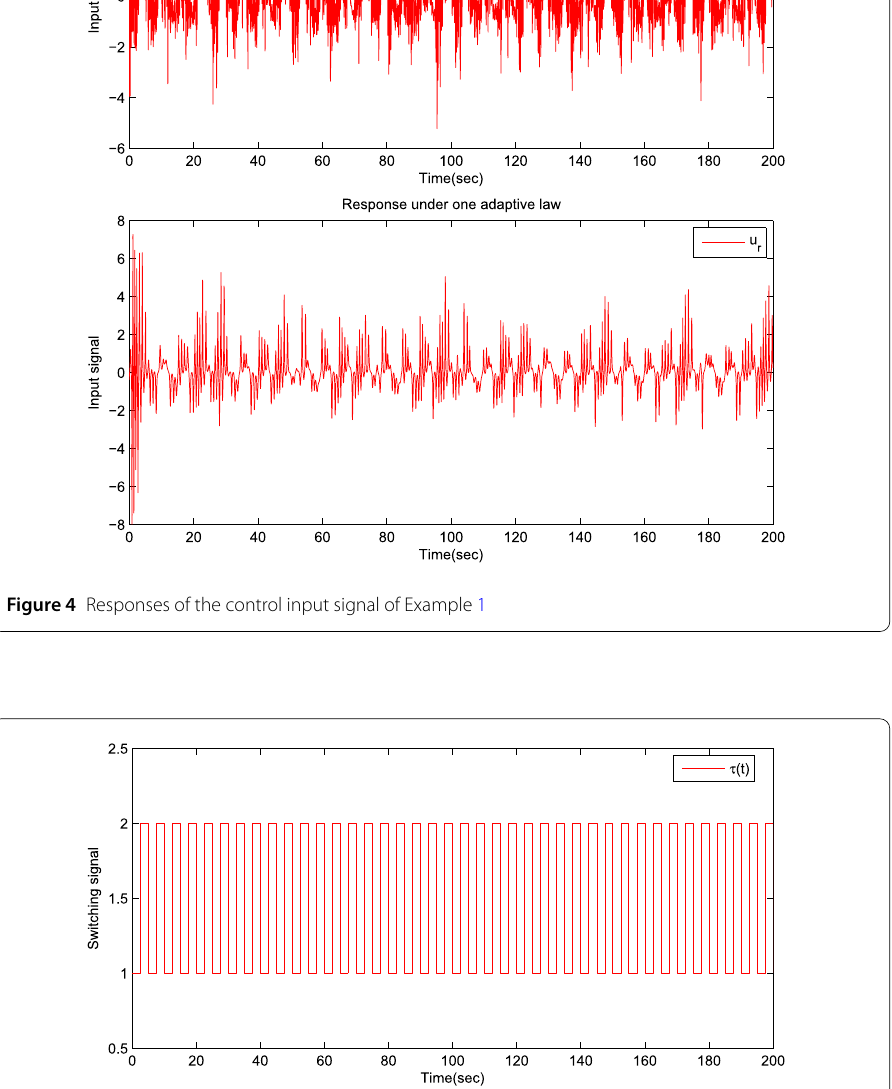
Figure 5 Responses of the control switching signal of Example